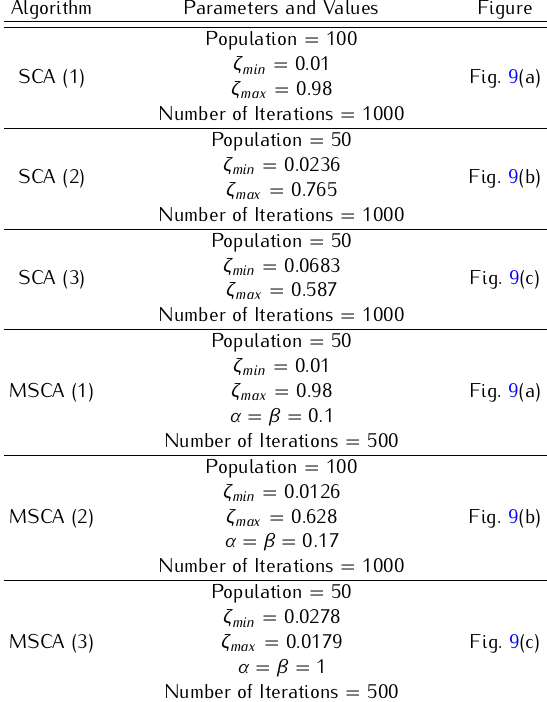
Table 3. Parameter values for comparison between SCA and